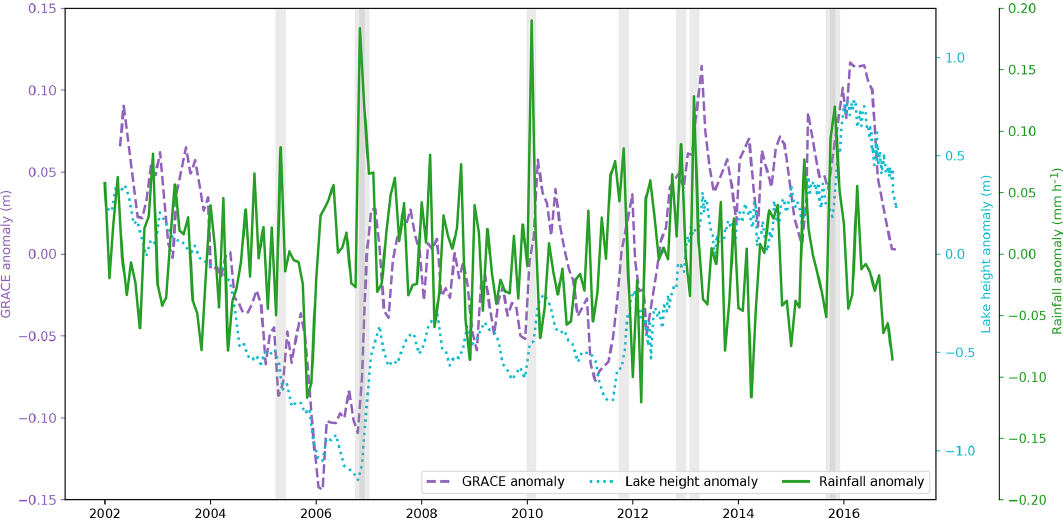
Figure 7. Monthly anomalies of precipitation over the Lake Victoria basin from the Tropical Rainfall Measuring Mission (TRMM, green), GRACE LWE over the basin (purple) and Lake Victoria water height (cyan). Anomalies represent the departures from the mean of each month between 2002 and 2016 to remove seasonal cycle influence. Grey shading indicates 3-month periods centred on months where the precipitation anomaly was greater than the 95th percentile. These periods coincide with rises in both LWE and lake height anomalies, highlighting the role of heavy rainfall on lake level